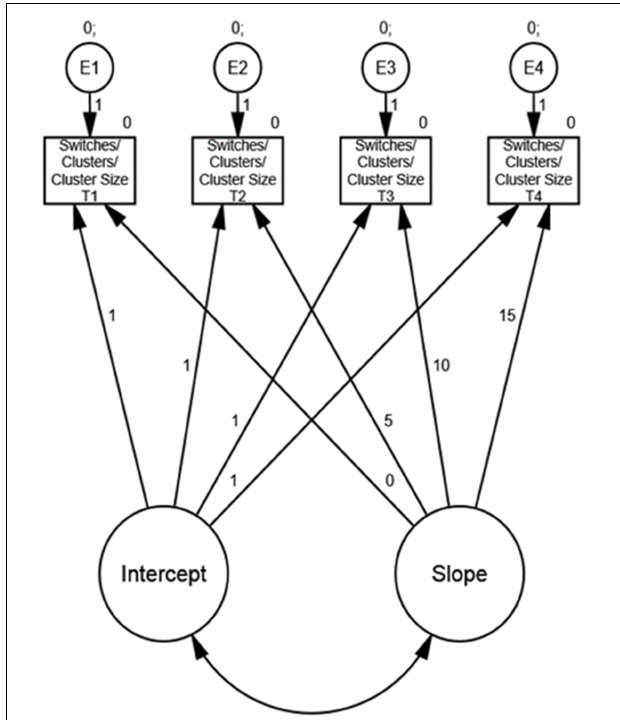
FIGURE 1 | Unconditional LGM. Numbers show a priori regression weights.